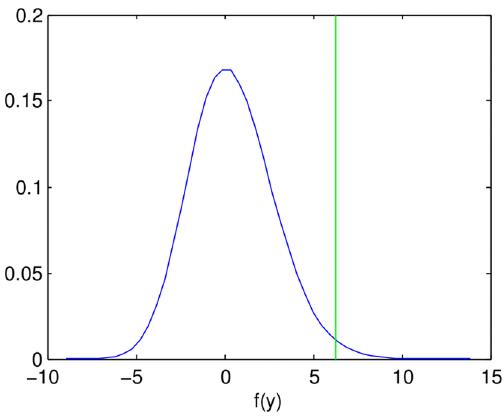
Figure 2. Histogram of phenotype f ( y ) values of 10 5 uniformly random sequences for the inferred epistatic model. Random sequences have very low inferred phenotype values because of the specificity of binding sites. The peak of the distribution indicates what phenotype values evolve under neutral conditions. The the wild-type value, b 0 (green line), is much higher than the neutral value indicating selective pressure.